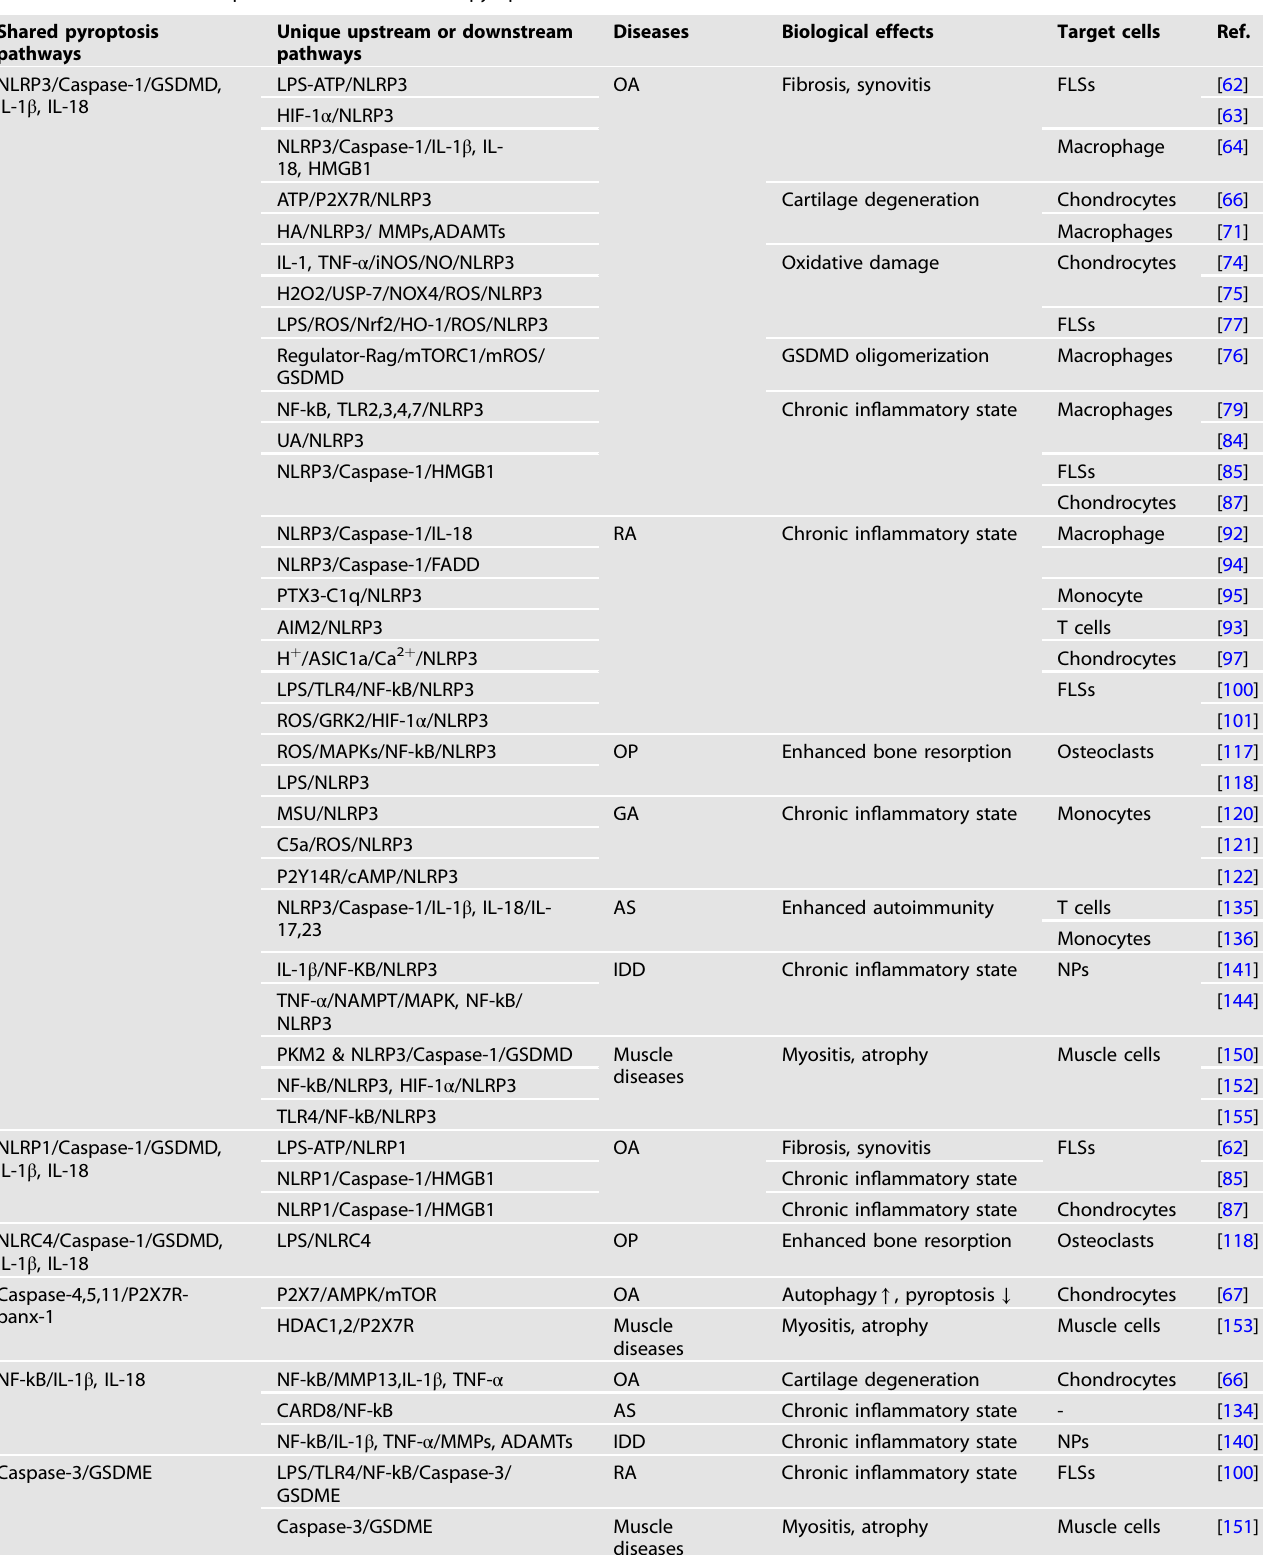
Table 2. Common and unique mechanisms related to pyroptosis in